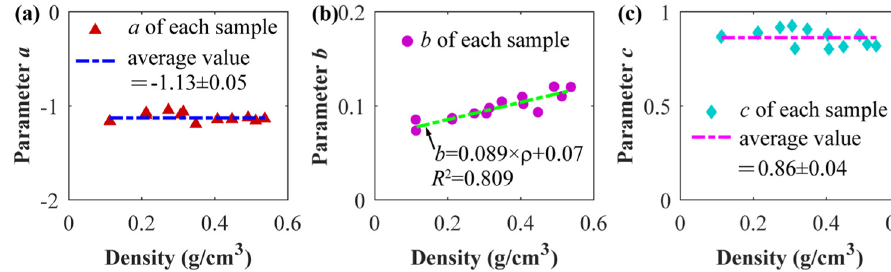
Figure 10: The variation laws of the undetermined parameters: ( a ) a, ( b ) b, and ( c ) c, in equation ( 9 ) with density.